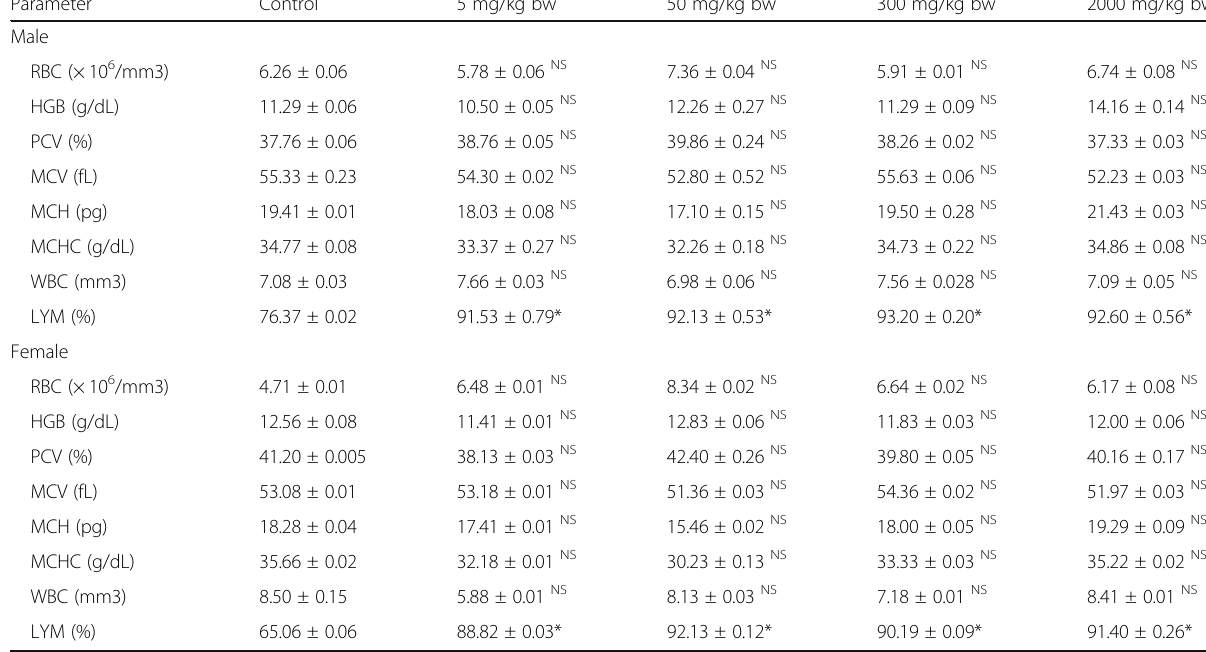
Values represent the mean±SE. NS not significant. SE significant error. * P